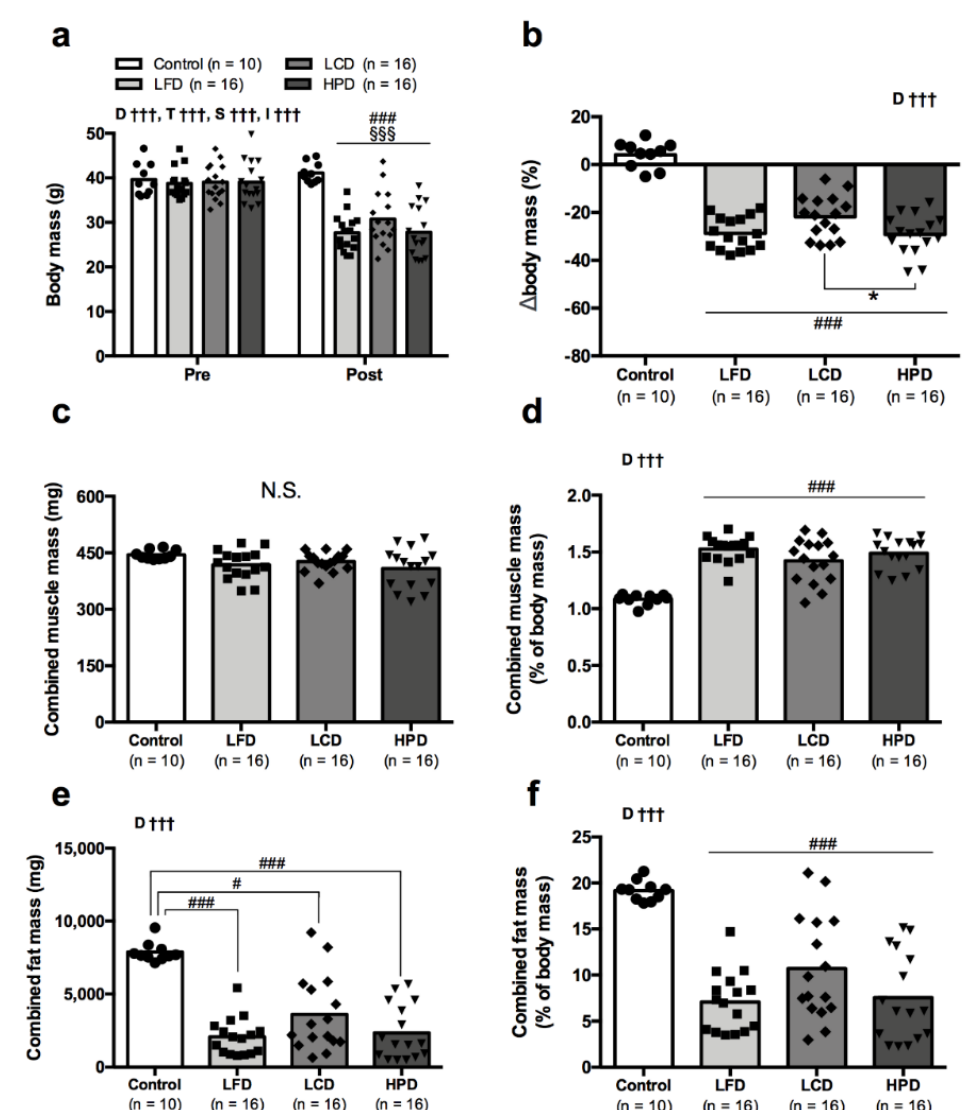
changes in the skeletal muscle mass which was not affected by the diets (Figure 1c). CR was associated with increase ( p < 0.001) in relative muscle mass expressed as percentage of body mass for three diet groups (Figure 1d). In contrast to muscle mass, the combined fat mass was greatly reduced ( p < 0.02–0.001) in all CR groups compared to the age-matched obese controls (Figure 1e). CR-induced decline in body fat was also significant ( p < 0.001) for all three diets when fat mass was expressed as percentage of body mass (Figure 1f).